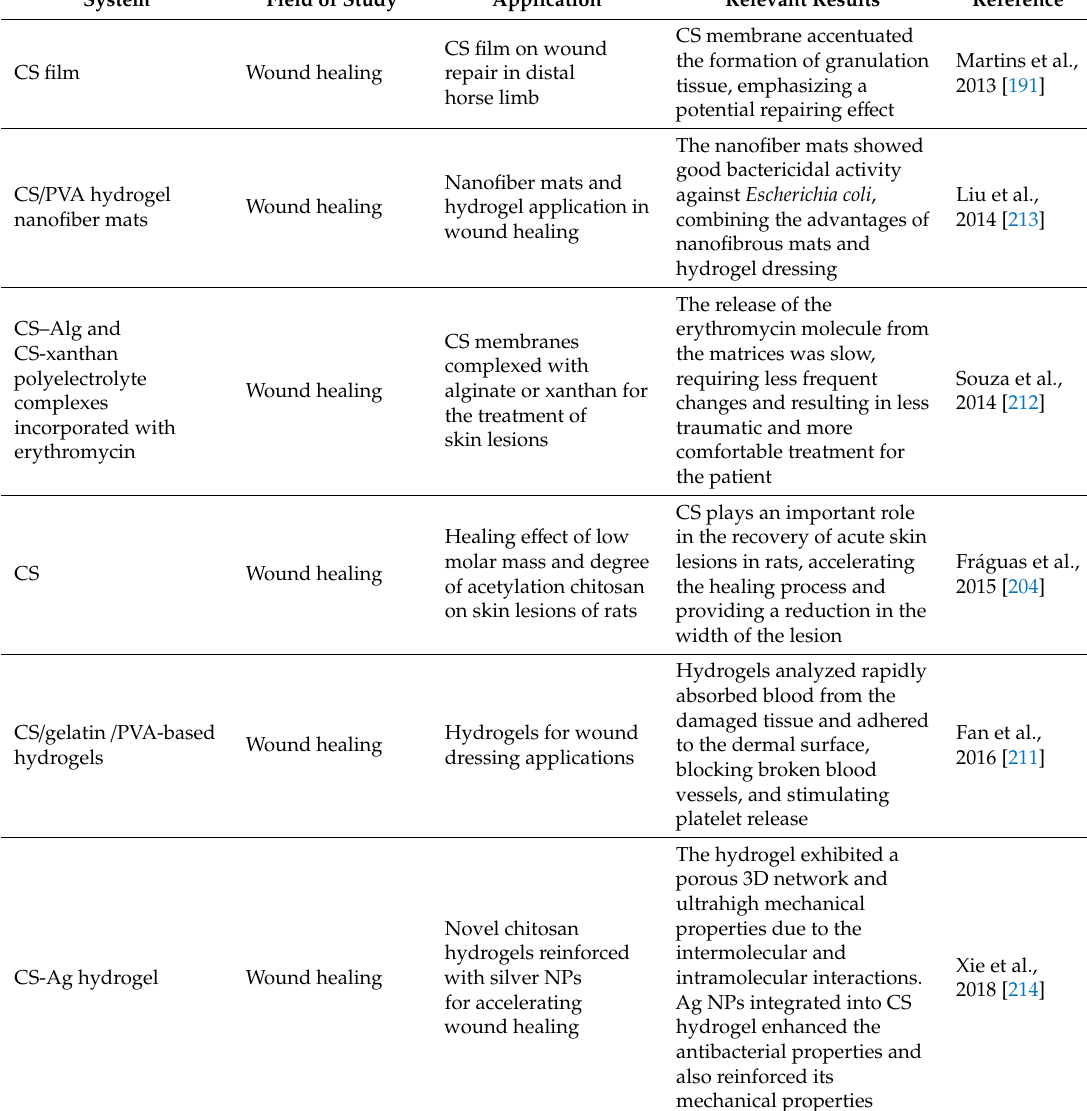
Table 1. Studies of chitosan (CS) uses in tissue engineering and wound healing over the last 10